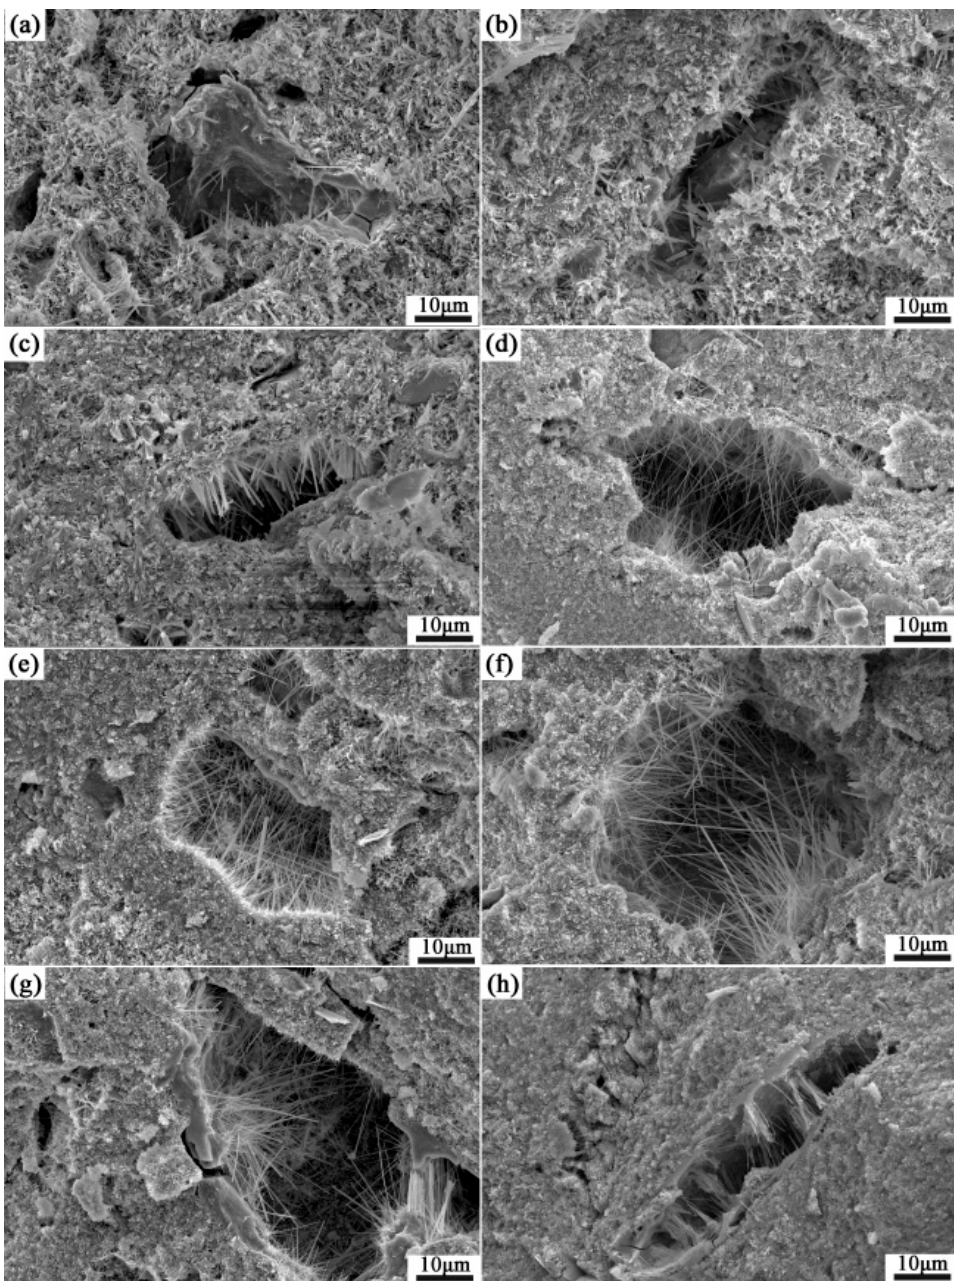
Figure 3. SEM images of the fracture surface of ( a ) MOC-3 adhesive; ( b ) MOC-4 adhesive; ( c ) MOC-5 adhesive; ( d ) MOC-6 adhesive; ( e ) MOC-7 adhesive; ( f ) MOC-8 adhesive; ( g ) MOC-9 adhesive; ( h ) MOC-10 adhesive.